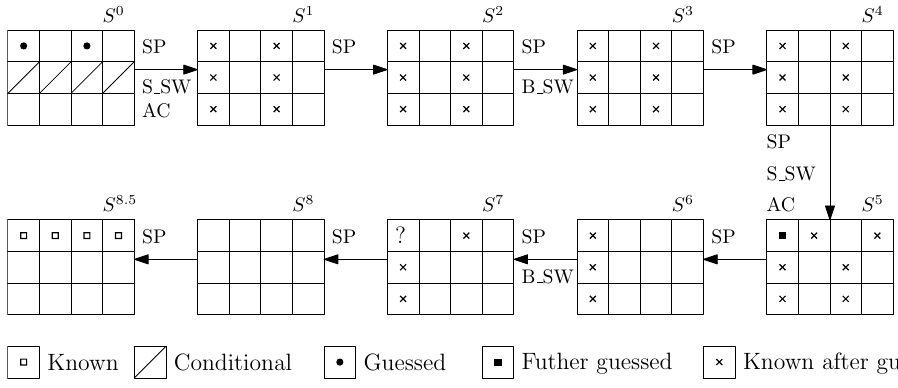
Figure 9: Illustration of the preimage attack on 9-round